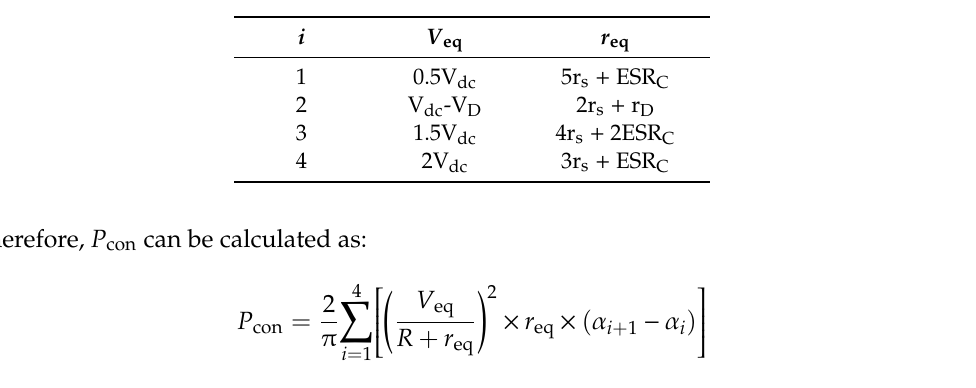
Table 2. Equivalent parameters of each mode.